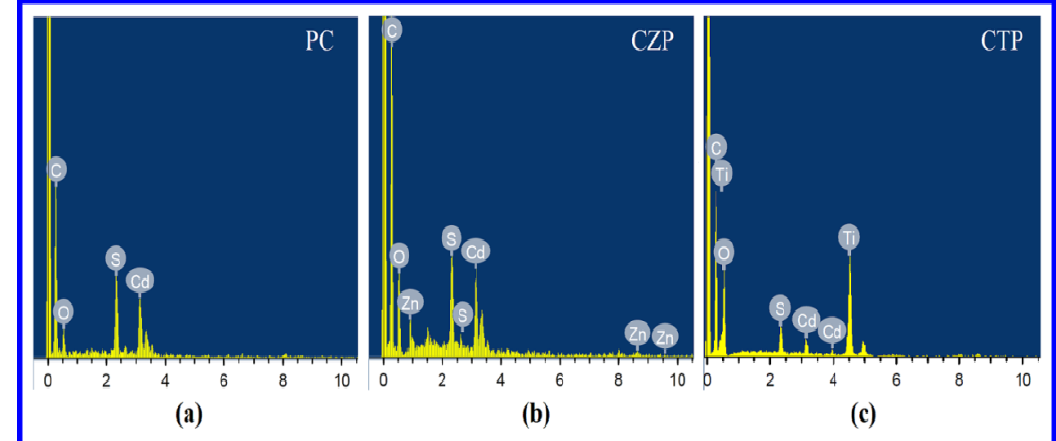
Figure 2. EDS spectra of ( a ) PC, ( b ) CZP and ( c ) CTP.